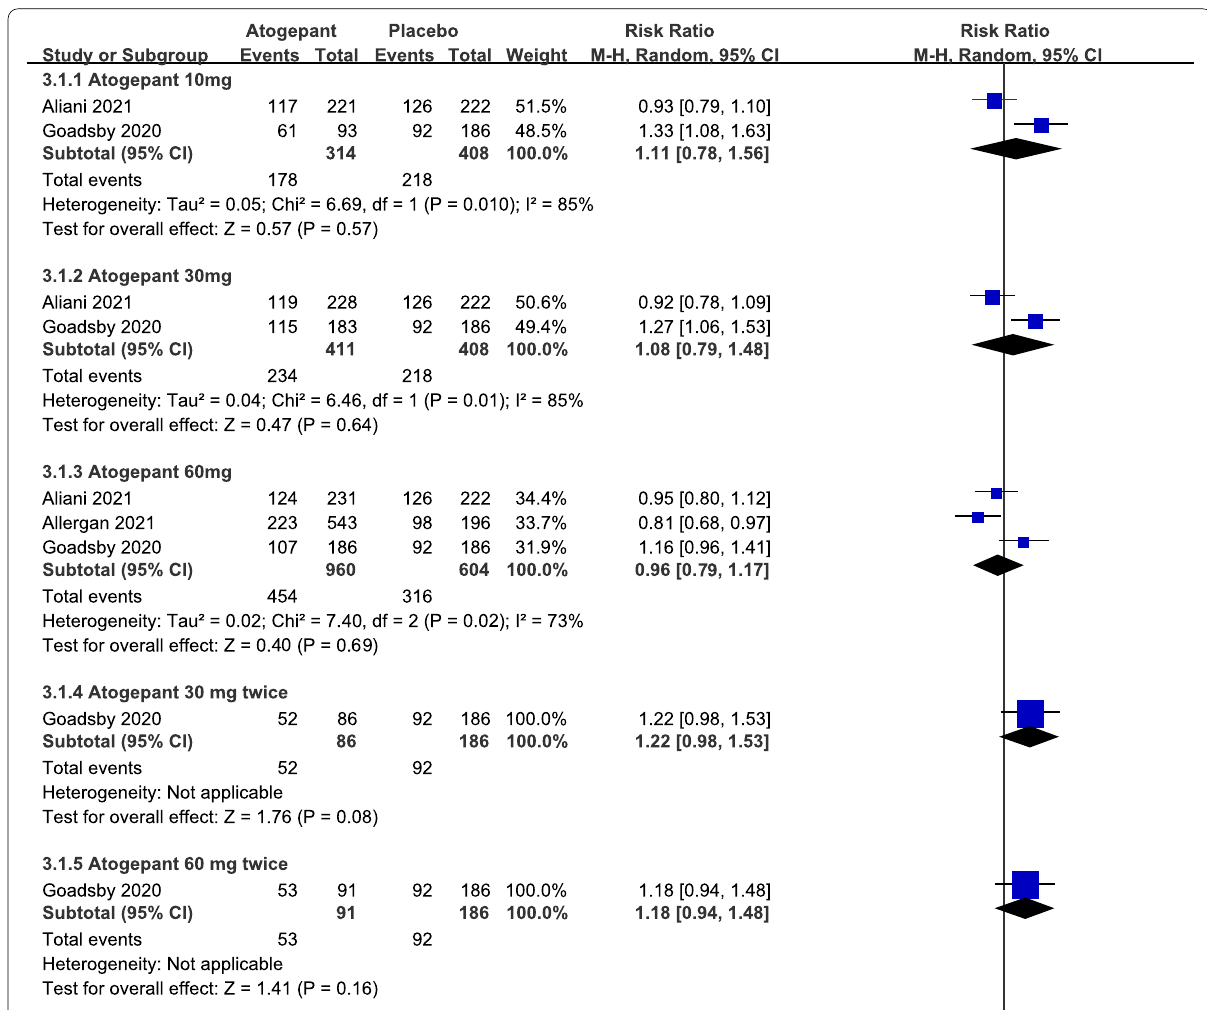
Fig. 6 The pooled RR of 50% reduction in adverse events. The blue square indicates the estimated RR for each RCT. The size of blue square ≥ indicates the estimated weight of each RCT, and the extending lines indicate the estimated 95% CI of RR for each RCT. The black diamond indicates the estimated RR (95% CI) for all patients together. CI, confidence interval; RCT, randomized controlled trial; RR: risk